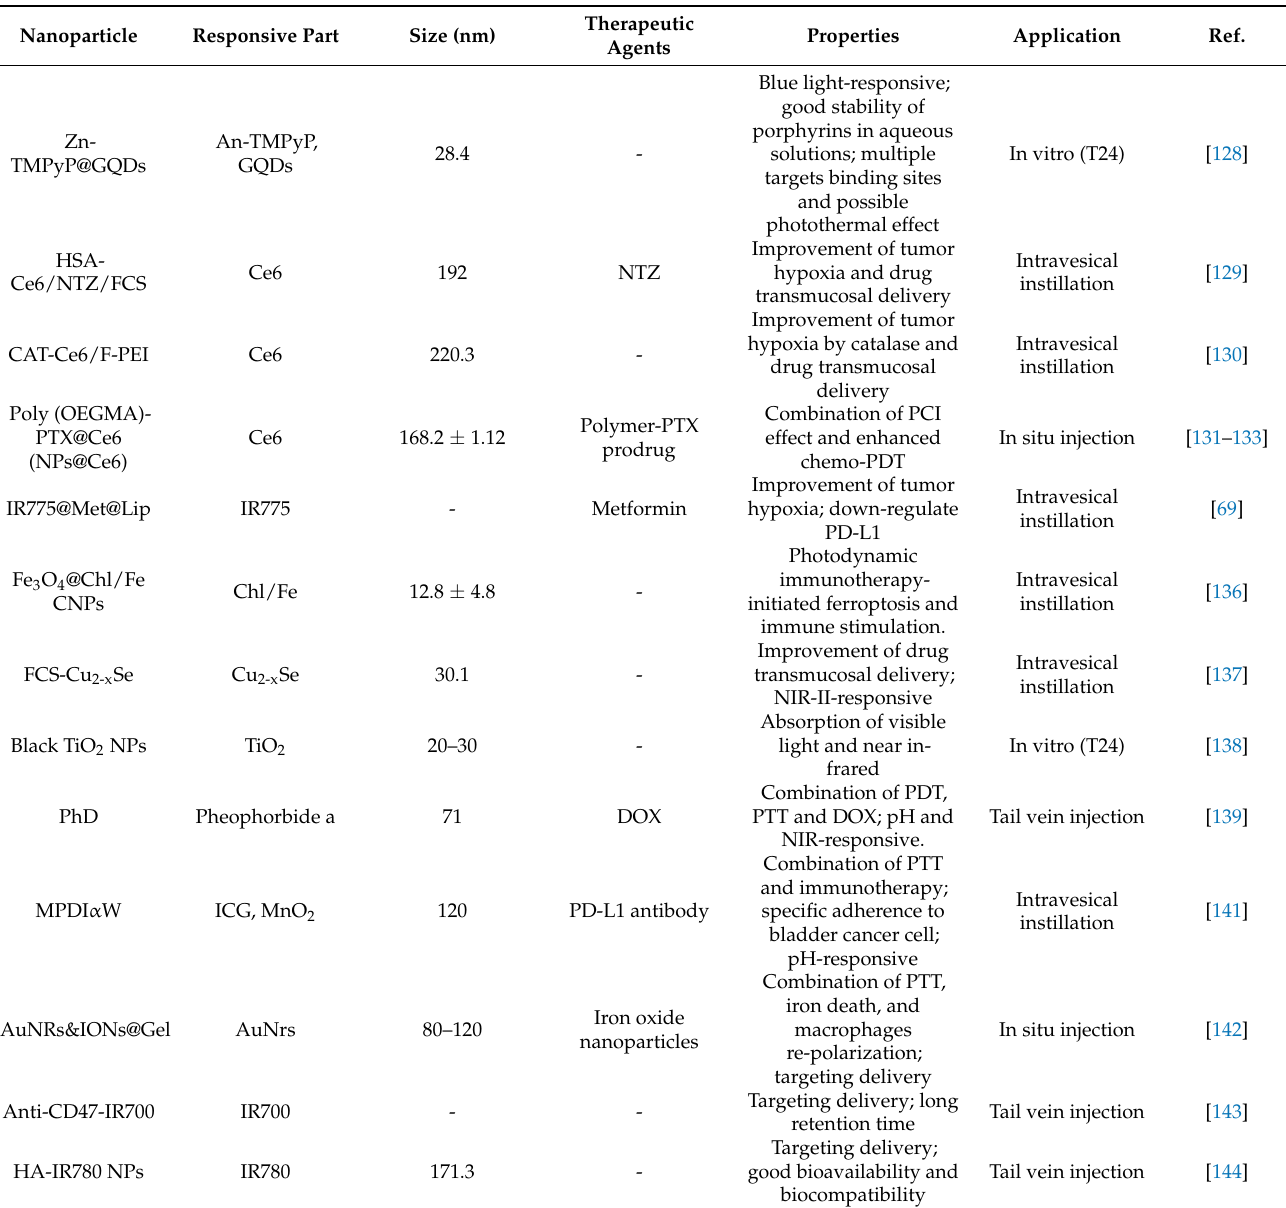
Table 7. Nano-formulations for light-based